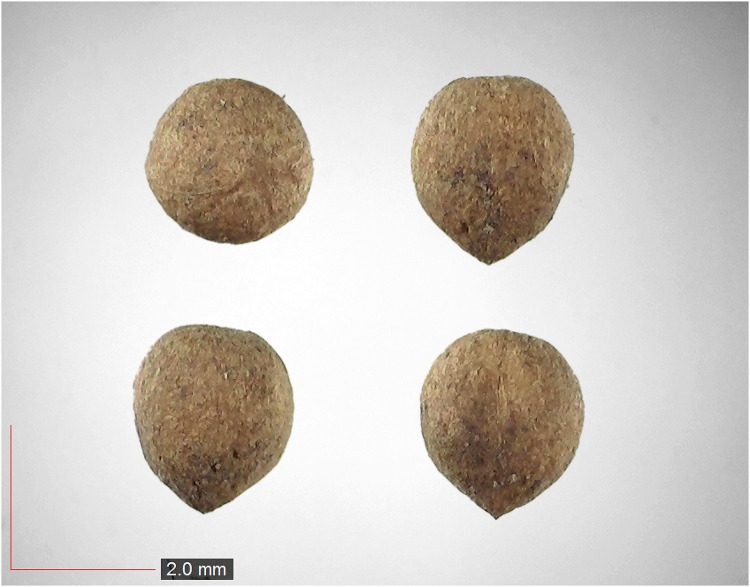
Unidentified 3.Table 2.